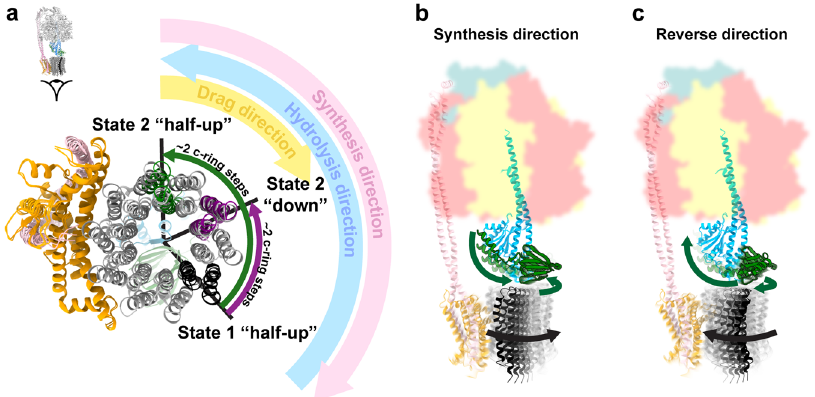
Fig. 8 Rotation in the F o motor in the half-up and down sub-states. a The F o rotor of the State 2 down sub-state trails the State 2 half-up sub-state by two c subunit steps in the synthesis direction. b When the F o motor is driven in the synthesis direction, the central stalk is unclamped and the ε NTD is pushed away from the ε CTH1 binding site on γ , reducing the likelihood of the up conformation. c When the F o motor is driven in the reverse direction, the central stalk is closed and the ε NTD is pushed towards the ε CTH1 binding site on γ , increasing the likelihood of the up demonstrates that the ε CTD can form the down conformation in ATP concentrations are likely to regulate the ε CTD conformation the absence of ATP 20 . Further to this, studies on Caldalakliba- and the single ε CTD helix is unable to clamp the central stalk in cillus thermarum F 1 -ATPase have also shown that removal of the the manner we observe in E. coli ATP synthase. The ATP binding ε subunit ATP binding site has little effect on activity or con- af fi nity for the isolated E. coli subunit ε has been shown to be much weaker than Bacillus PS3, with little discrimination between formation of the ε CTD 55 . Hence, other mechanisms in addition ATP and ADP ( Kd of ~20 mM for both ATP and ADP 13,52 ). The to ATP binding could potentially control the conformation of the ε CTD in E. coli and other related bacteria. crystal structure of the isolated ε subunit from E. coli also